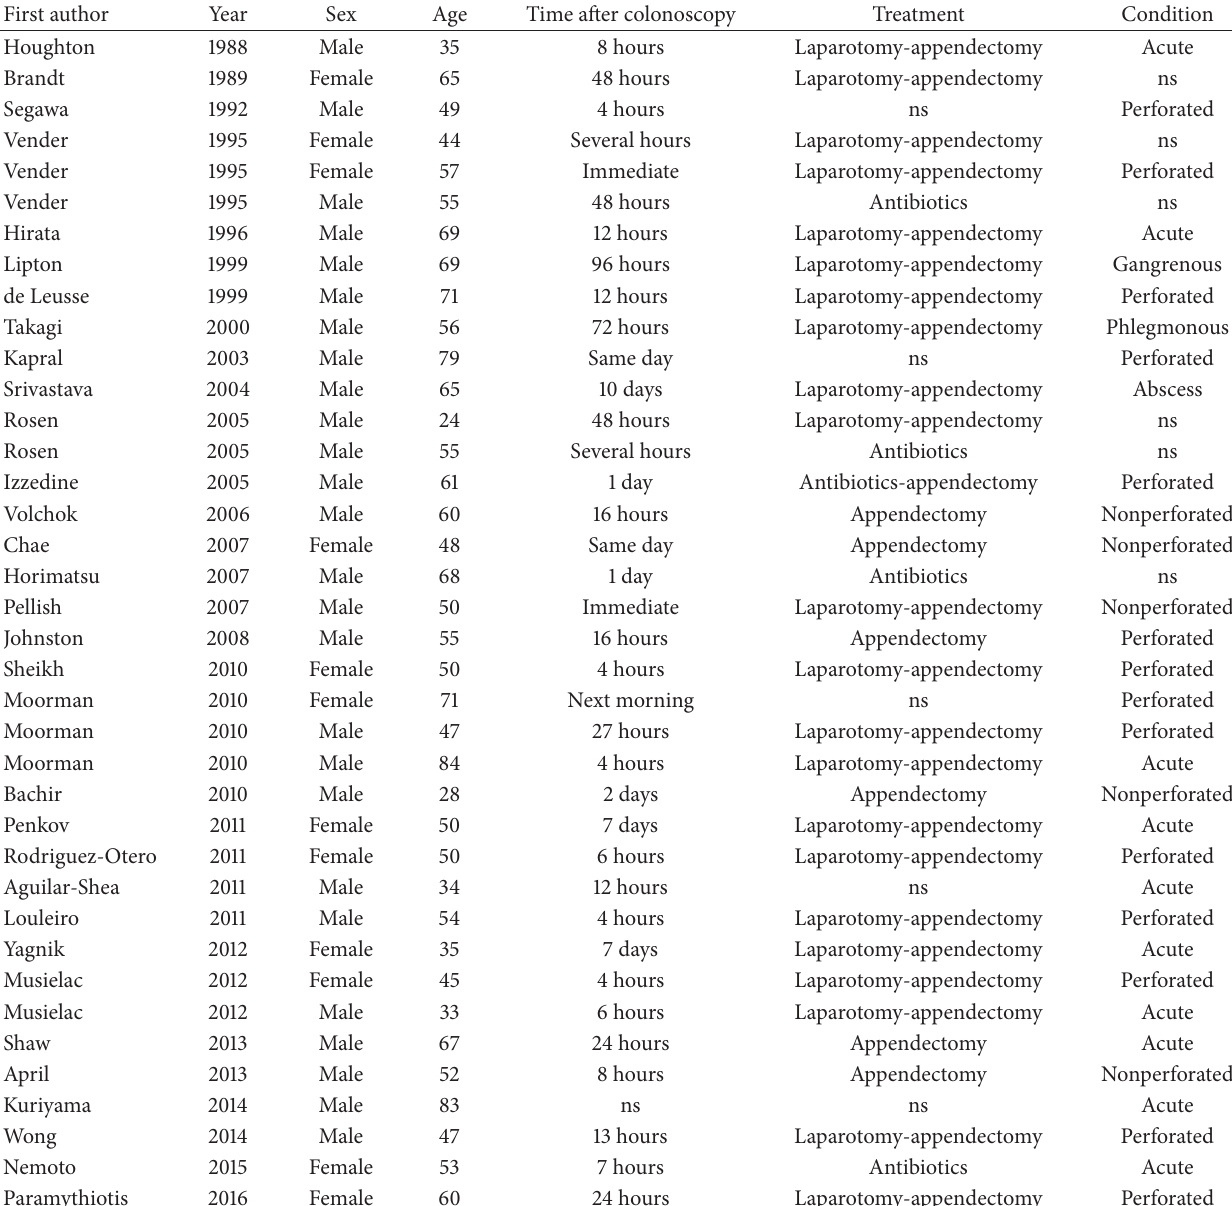
Table 1: Presentation of main characteristics of cases described in the literature (ns: not